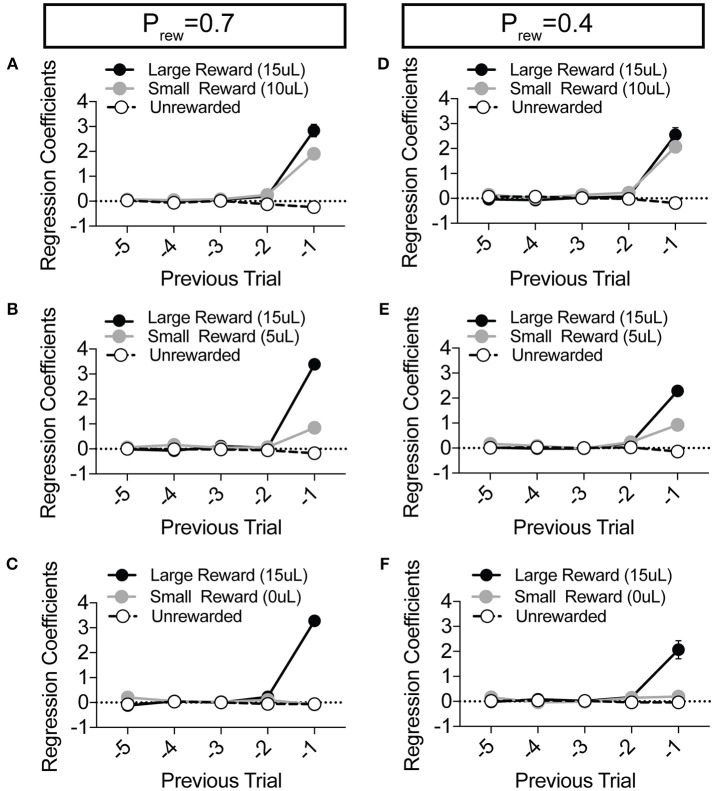
Choice is largely influenced by the T−1 trial in a relative reward environment. (A–F) The average coefficients for the multivariate logistic regression model that describes previous choice and reward history. (Prew = 0.7, n = 11; Prew = 0.4; n = 10) For each of the relative reward regimes tested, note that the T−1 trial is significant for large reward outcomes. For relative reward regimes with 10 μL (A,D) and 5 μL (B,E) small reward outcomes we note a significant T−1 coefficient. We detect no significant T−2 (or further) coefficients indicating that mouse choice is largely dictated by the outcome of the T−1 trial.